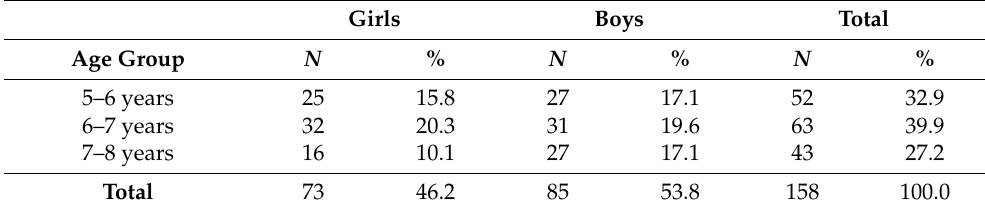
Table 1. Distribution of age and gender groups in the